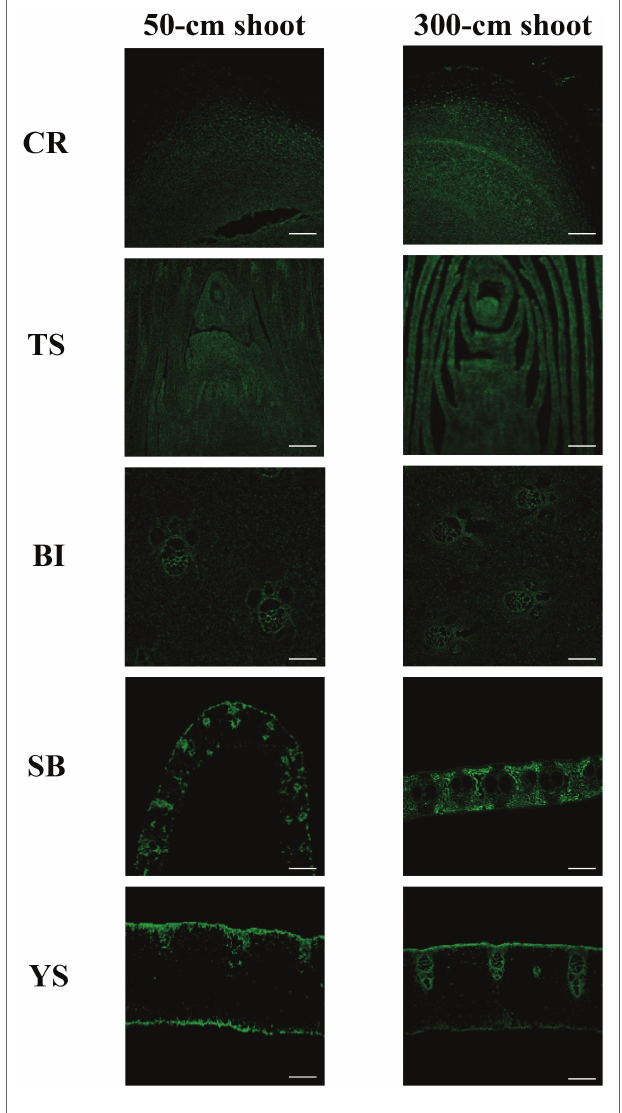
FIGURE 2 | IAA immunofluorescence localization. CR root tip (the tip of the bamboo root growing out of the base of the bamboo shoot), TS tip of shoot, SB sheath blade (the upper component of culm sheaths, the base is connected to the tip of sheath and is the metamorphic leaf of bamboo shoot), BI bamboo shoot internode 1/5 from the tip, and YS young sheath. Bar = 50 μ